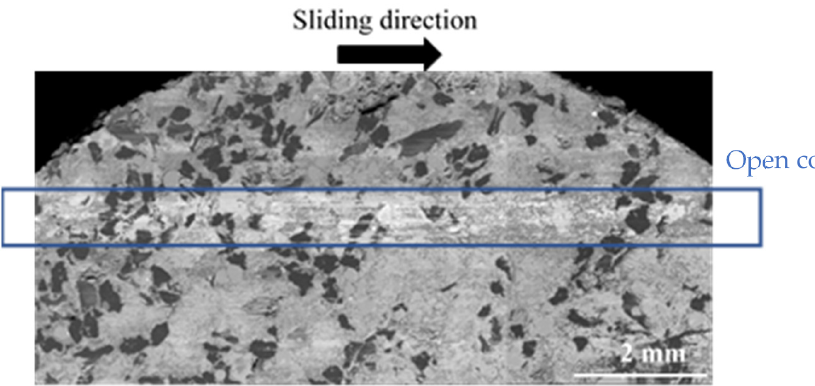
Figure 13. Open contact area at the IR (SEM and BSE).